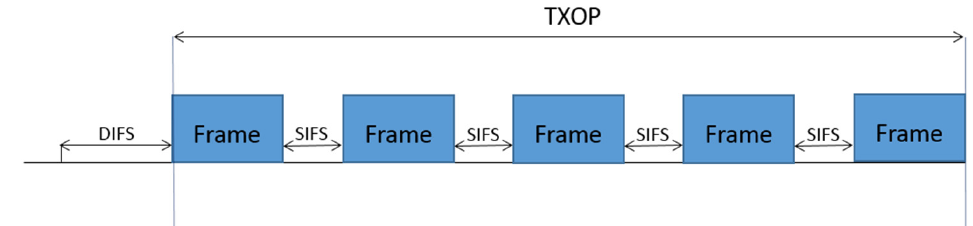
Figure 2. Example of a standard-compliant transmission using a Transmission Opportunity (TXOP).